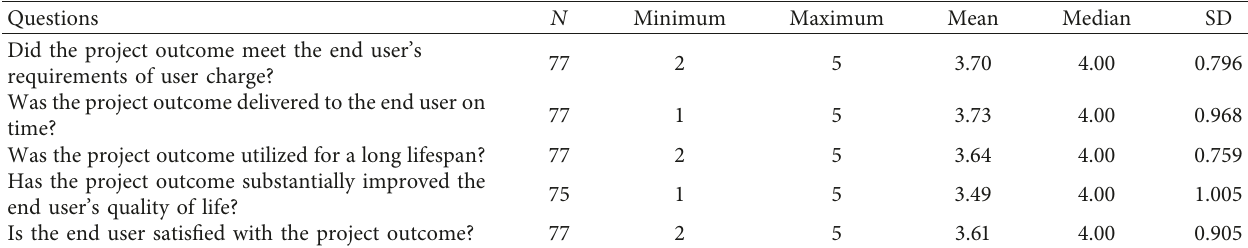
Table 4: Descriptive data of the project success dimension “benefits to end user.”